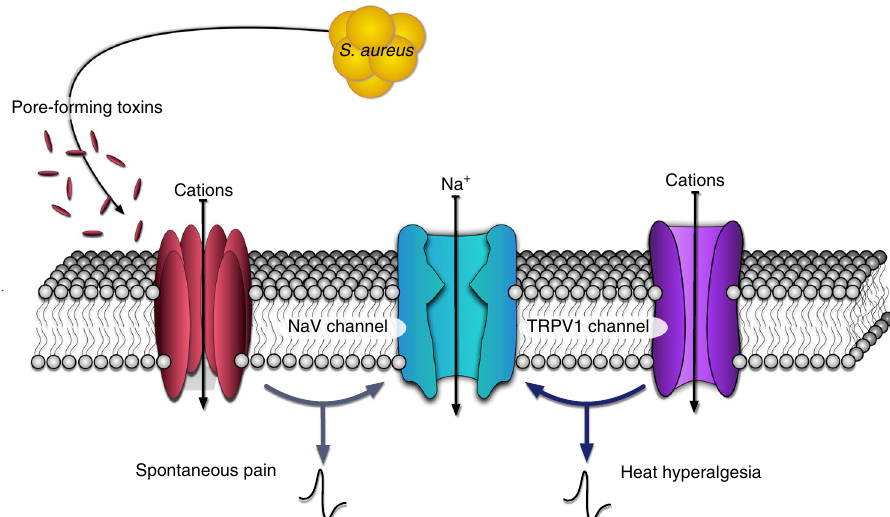
Fig. 8 Molecular mechanisms of pain during live S. aureus infection. S. aureus induces signi fi cant spontaneous pain mediated by PFTs. S. aureus secretes several types of PFTs including α -hemolysin, PSM α 3, and HlgAB, which can form pores in DRG neuronal membranes suf fi cient for cation in fl ux and action potential generation. All three types of PFTs produce spontaneous pain when injected into mice, but only α -hemolysin is necessary for S. aureus -induced spontaneous pain. As a separate pain modality, S. aureus induces signi fi cant heat hyperalgesia, which is dependent on TRPV1 ion